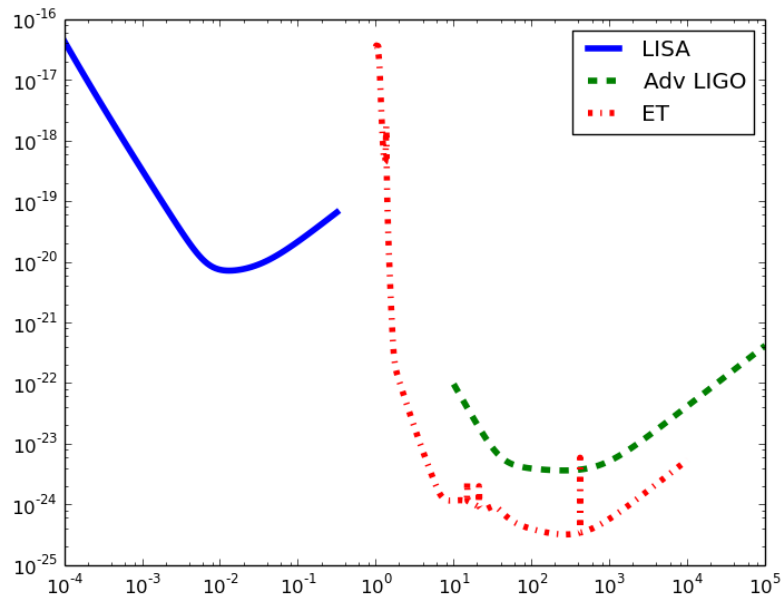
Figure 22. Planned noise curves for eLISA, Einstein Telescope/Cosmic Explorer and Advanced LIGO. The noise curves have been taken from Reference [71] for eLISA, from Reference [72] for Einstein Telescope and Reference [40] for Advanced